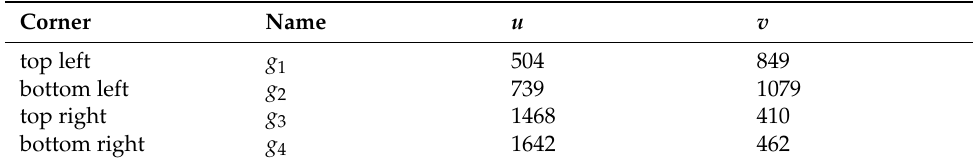
Table 3. Domain ˆ Q im corners coordinates in ˆ Φ